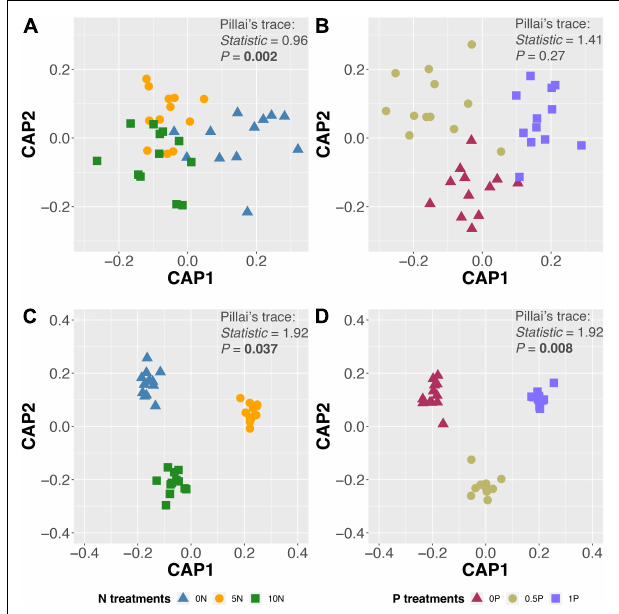
FIGURE 2 | Canonical analysis of principal coordinates (CAP) ordinations with fungal operational taxonomic unit (OTU) composition after short-term N (A) and P (B) additions, and long-term N (C) and P (D) additions. Treatment abbreviations as described in “Materials and Methods”